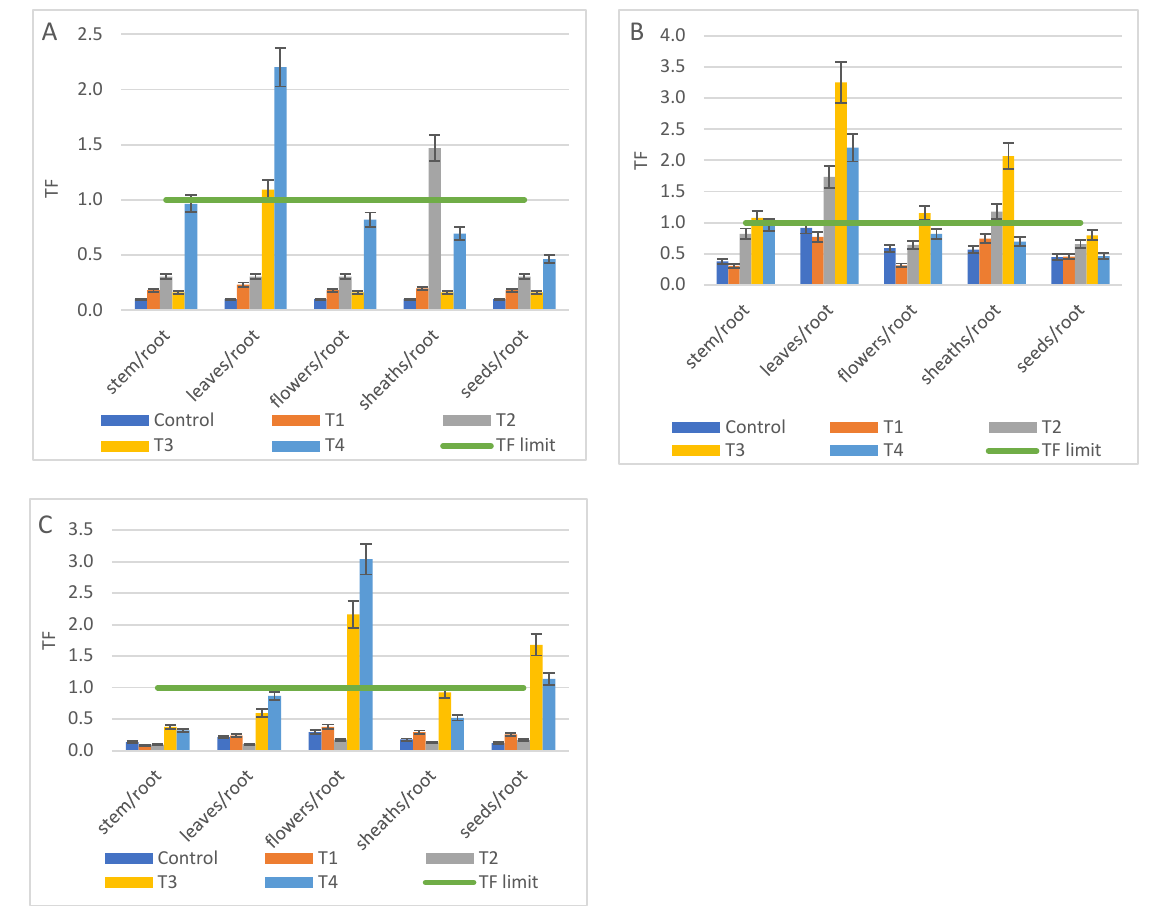
Figure 5. The translocation factor (TF) from root of S. alba to plant tissues in T1 to T4 treatments compared with control and TF limit = 1 (average ± SD, n = 6): ( A ) As, ( B ) Cd, ( C ) Ni.